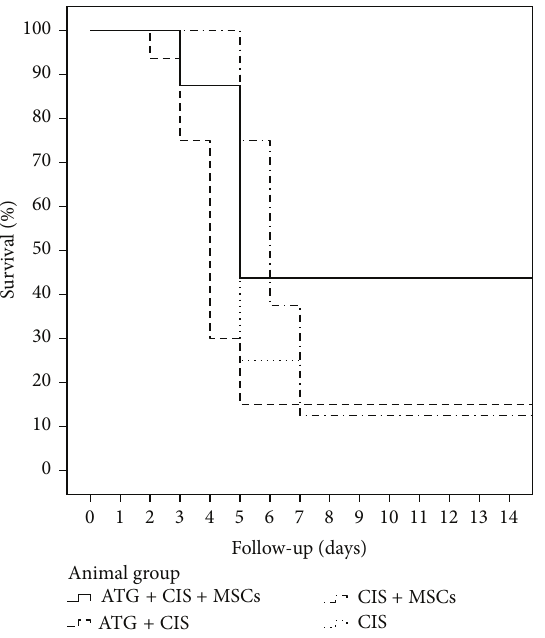
Figure 3: Schematic representation of survival curves in BALB/ cOlaHsd cisplatin treated mice. The survival was estimated by Kaplan-Meier statistical analysis. Mice pretreated with ATG had an increased survival after MSCs treatment during their follow-up (log rank 𝑝 = 0.012